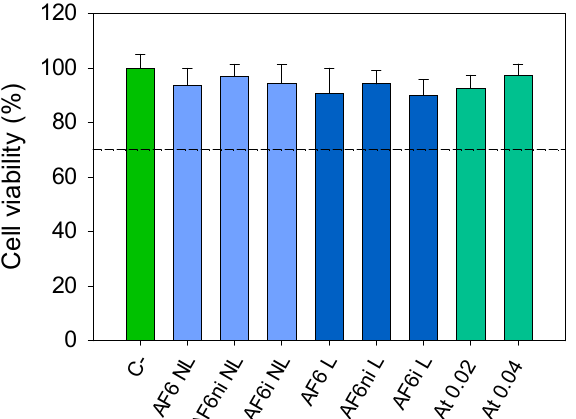
Figure 6. Viability of Balb/3T3 cells (%; mean and standard deviations) determined by CCK-8 assay, after 24 h exposure to nonloaded (NL), and atorvastatin loaded (L) hydrogels (AF6, AF6ni and AF6i) and two atorvastatin solutions (At; 0.04 and 0.02 mg/mL in ethanol:water 20:80 v/v ). Negative control (C-) cells cultured in the absence of any treatment. Dashed line corresponds to 70% cell vi- ability.